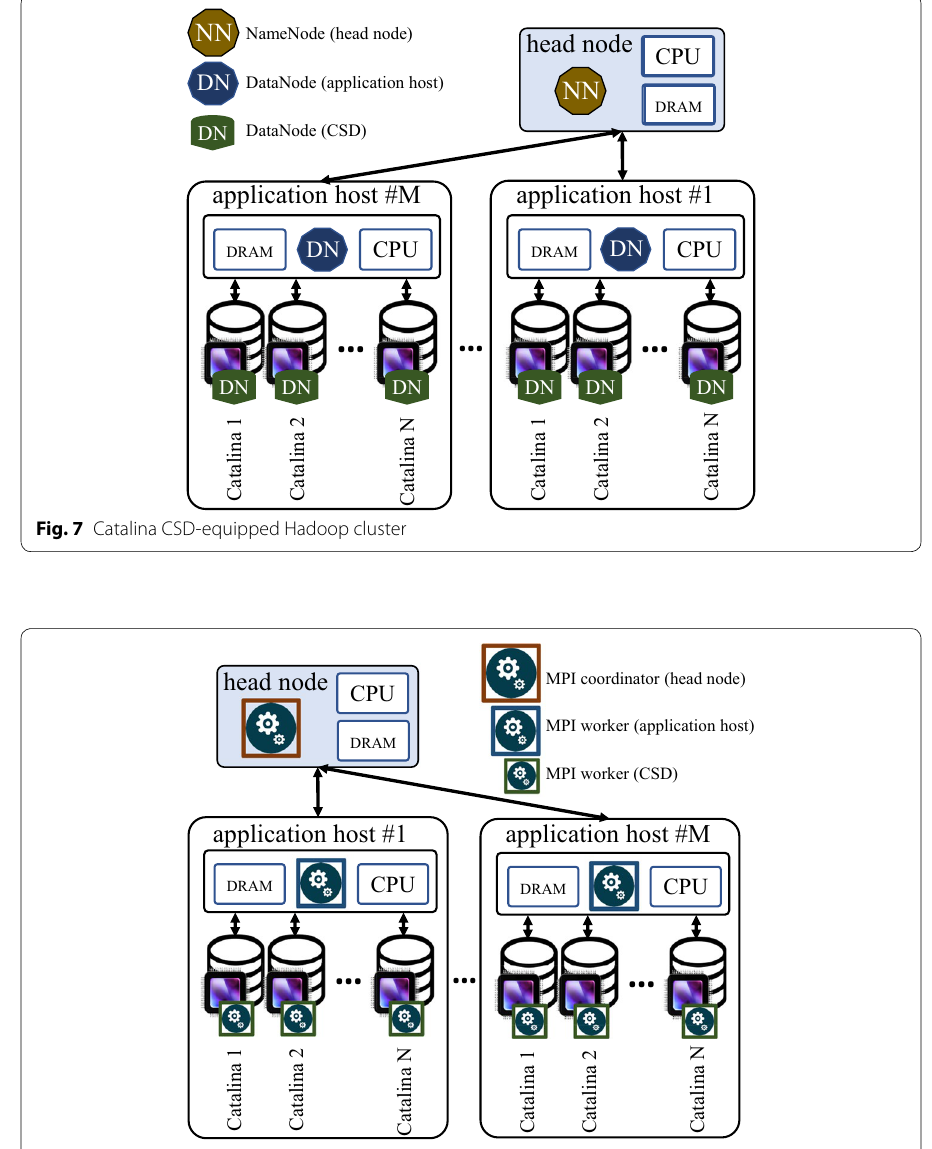
Fig. 8 Catalina CSD-equipped MPI-based